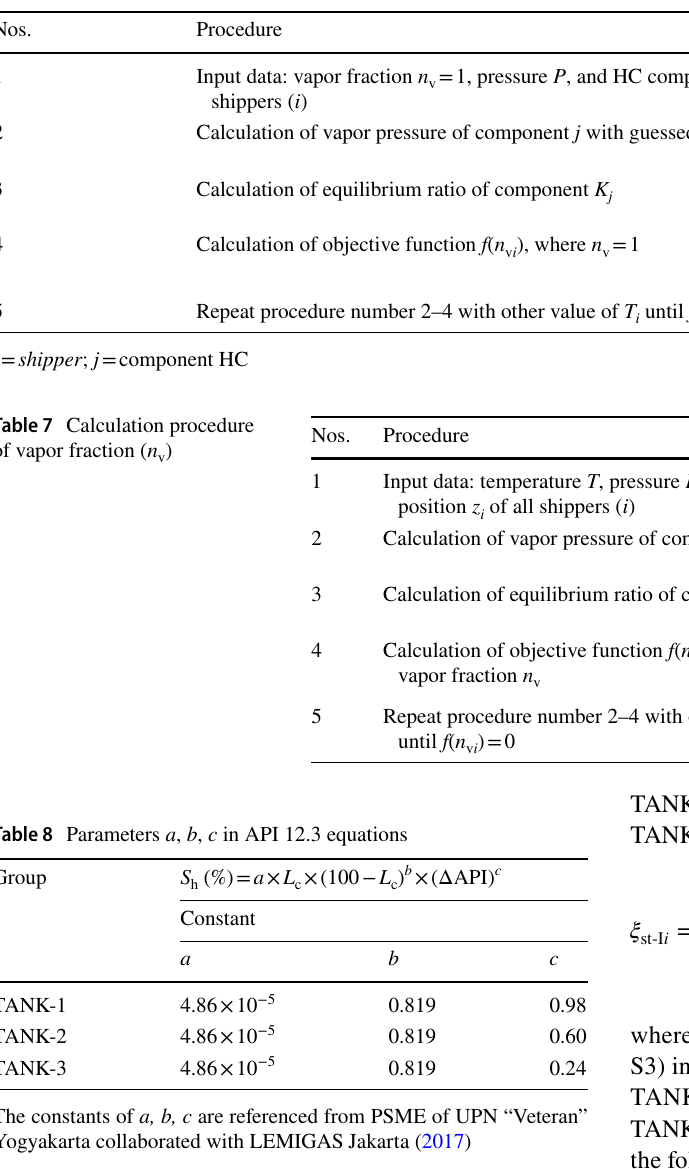
Table 6 Calculation procedure of dew point ( T